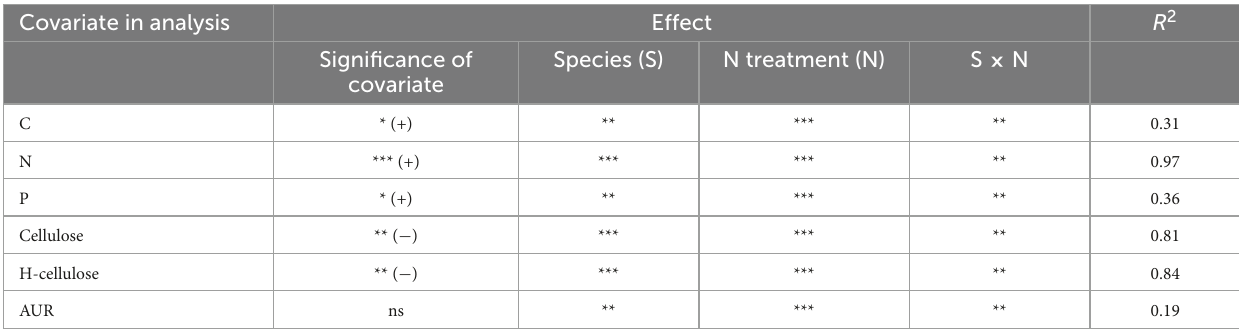
TABLE 2 The main effects of the N fertilizer treatment, species, and their interaction and the covariate effects of the initial substrate chemistry on the wood decomposition rate (k, month − 1 ). Covariate in analysis Effect R 2 Significance of covariate